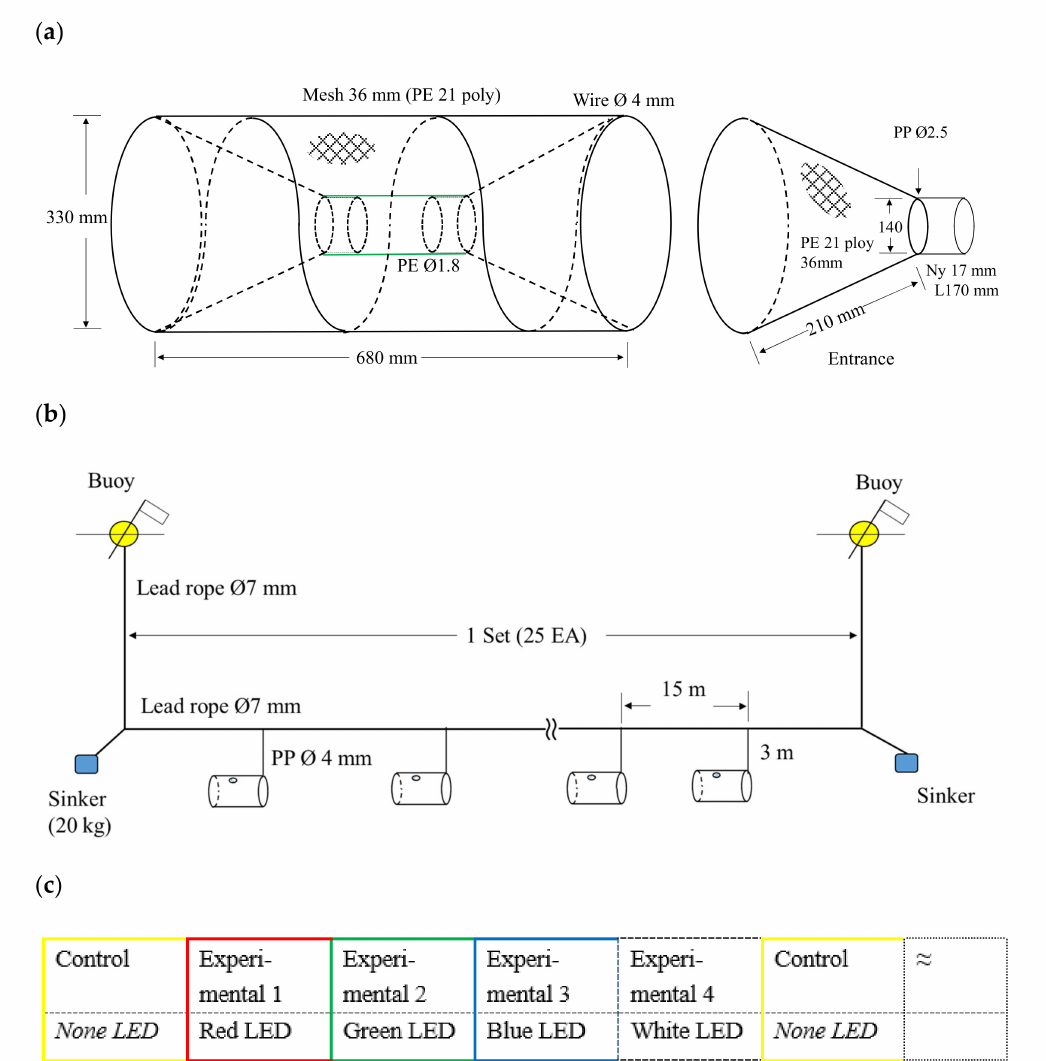
Figure 2. Fishing pots for bluefin sea robin in the experiments: ( a ) schematic drawing of a single pot; ( b ) composition of experimental fishing gear; ( c ) the arrangement of control and experimental pots for fishing gear